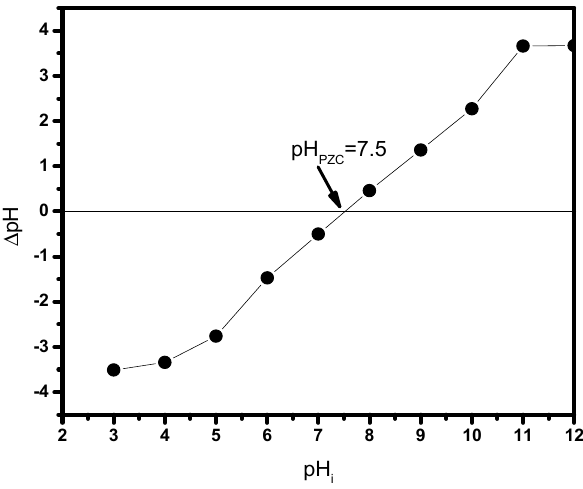
Figure 8. Plot of pH PZC for the prepared bio-composite.